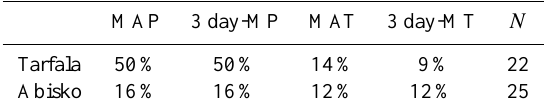
Table 6. Frequency that the DOY of the annual 1-day maximum precipitation (MAP), the annual 3-day maximum total precipitation (3 day-MP), the 1-day mean air temperature (MAT), and the annual 3-day mean air temperature (3 day-MT) were coincident with the maximum annual flood event. The results are shown for the com- parison period of 1985–2009.